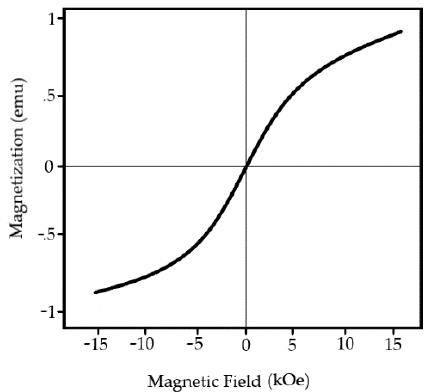
Figure 25. Hysteresis loop of Mullite ferrite material at room temperature.